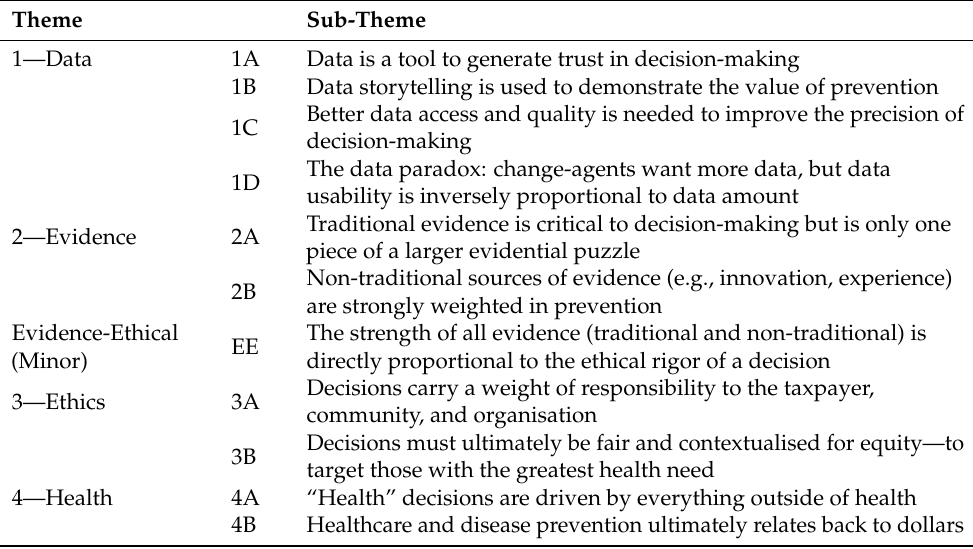
Table 3. Themes, sub-themes, and minor theme derived from researcher-led interpretation (stage two) of the Leximancer text analytics.